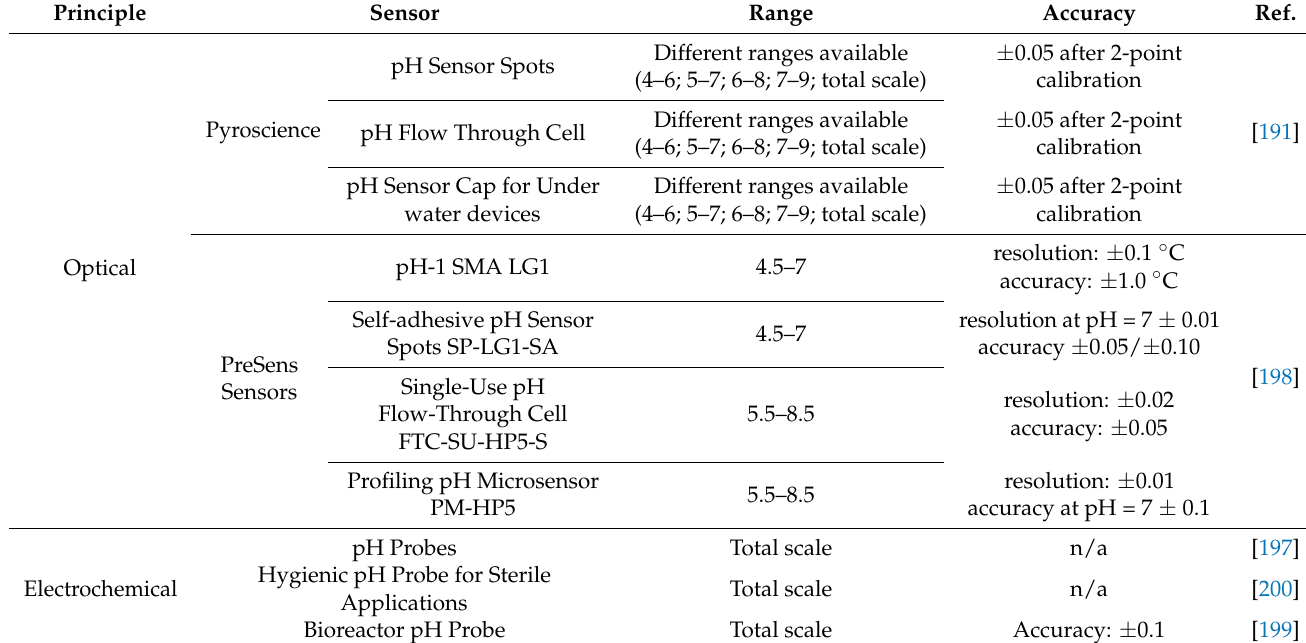
Table 3. Commercially available pH